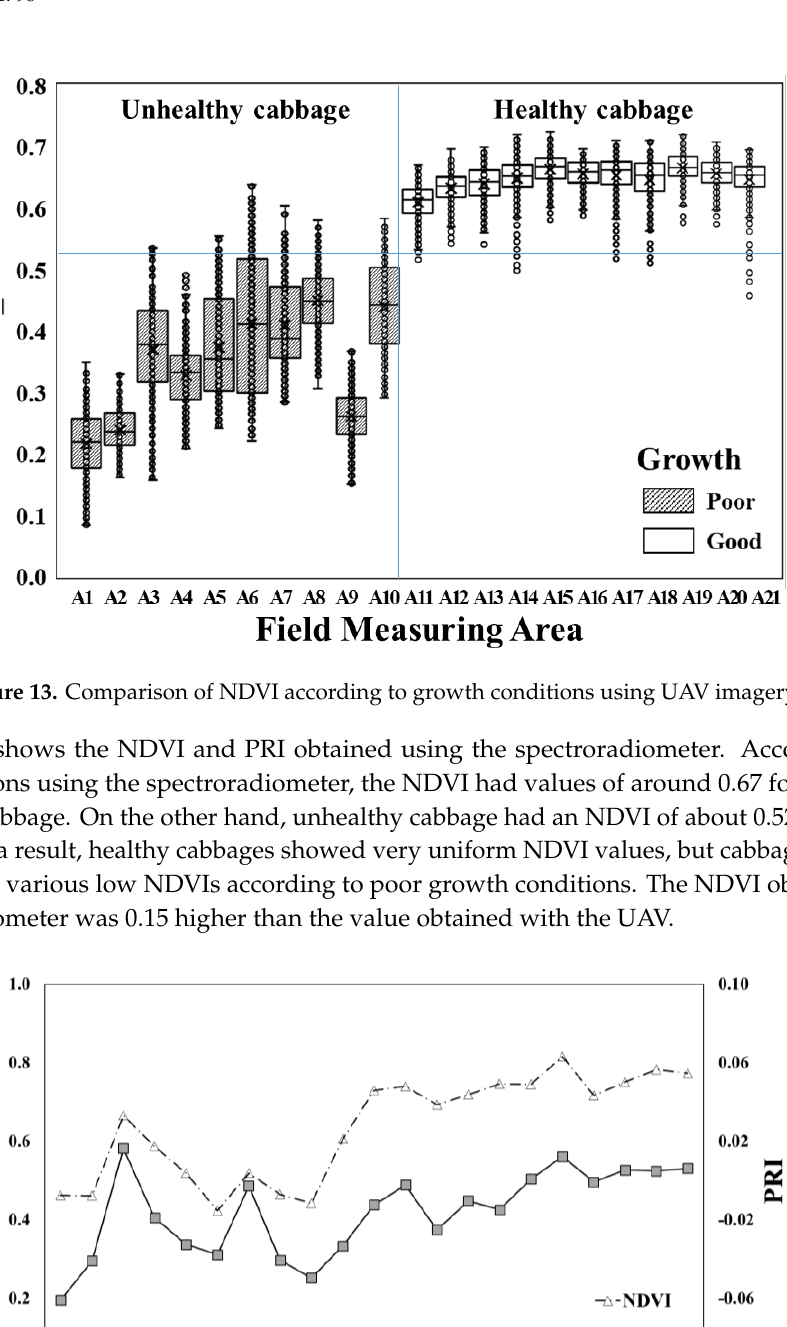
Figure 14. Comparison of NDVI and PRI obtained using a spectroradiometer according to the growth status of cabbage.